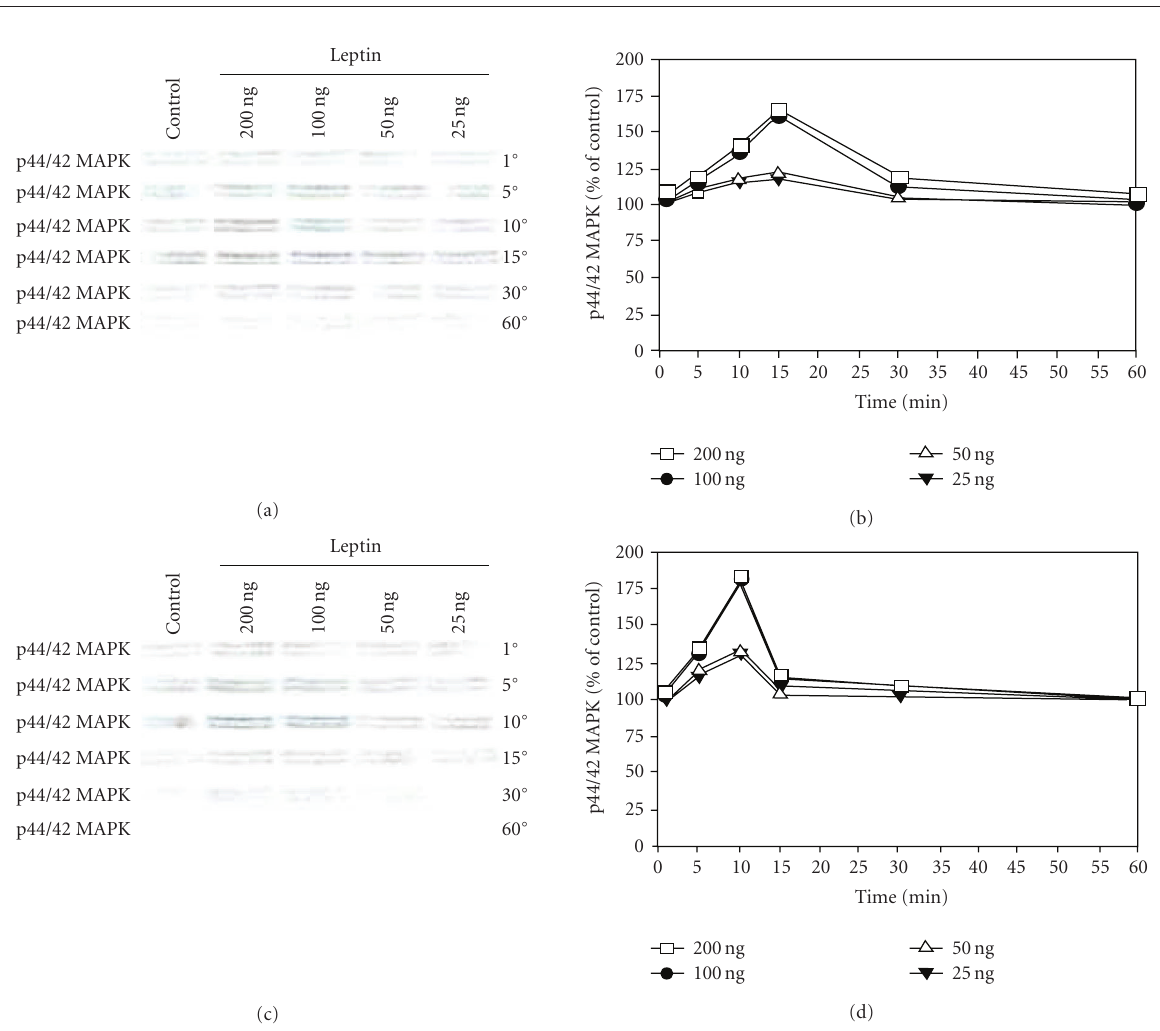
Figure 3: Leptin stimulates MAPK phosphorylation in PC-3 and DU-145 cells. Growth factor-starved PC-3 (a) or DU-145 cells (c) were exposed to increasing concentration of leptin for various time points. Cell lysates obtained after each time point were separated on a 7.5% SDS-PAGE and Western-blotted. Phosphorylated MAPK levels were obtained after incubation with p44/42 MAPK antibody and chemiluminescent detection. (b) and (d), levels of p44/42 MAPK obtained after densitometric analysis and represented as percentage of control against time (control being set at 100%). The results of one of the three independent experiments are